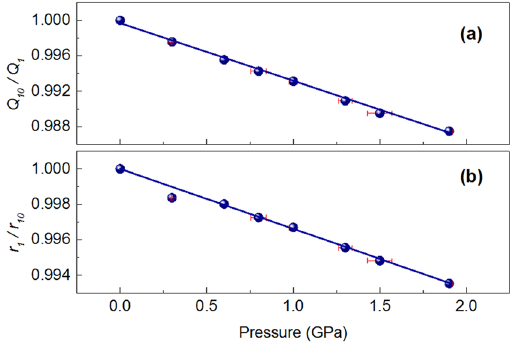
Figure 2. ( a ) The normalized first peak position Q 1 of the structure factor S ( Q ) and ( b ) nearest-neighbor distance r